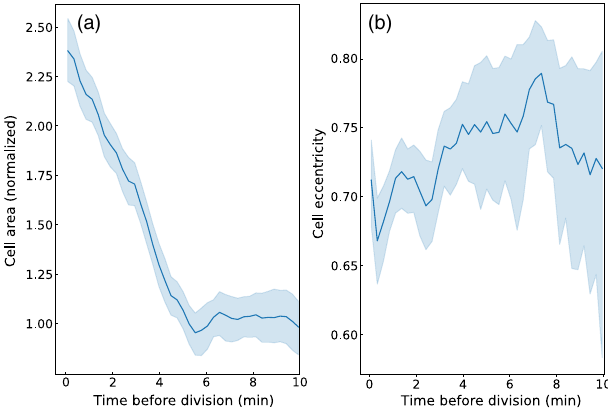
FIG. 13. Distributions of cell area (a) and cell eccentricity (b). Solid lines indicate means while surrounding outline indicates one standard deviation. We observe that the onset of the “ round- ing up ” of the cell and the start of area growth occurs at 5 min before